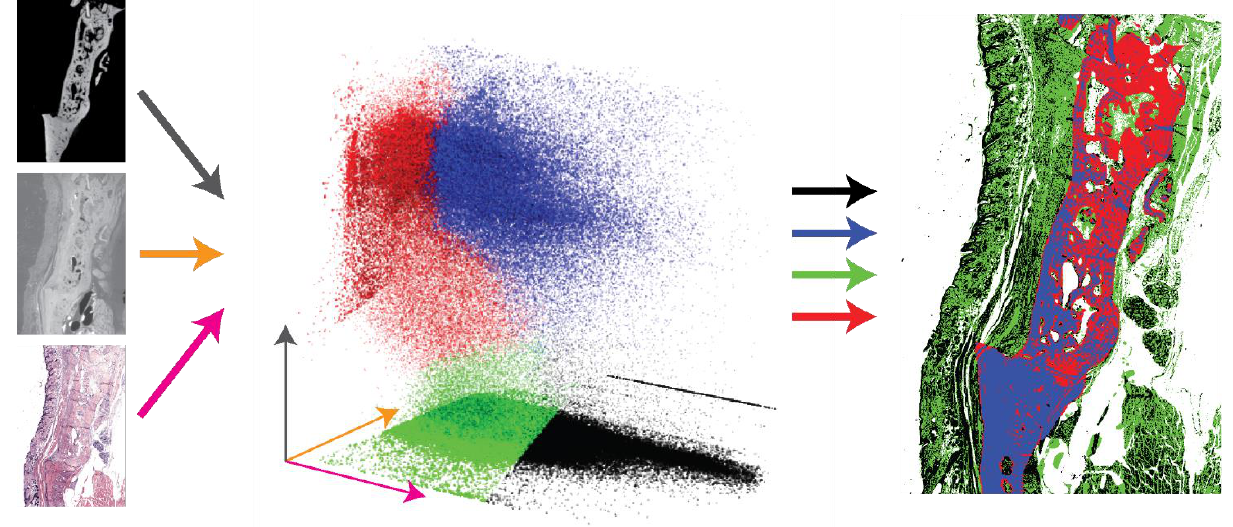
Figure 11. Using the corresponding pixel intensities of the three slices from conventional µCT before decalcification, from SRµCT after decalcification and from H&E-stained histology, a trivariate histogram was built. After applying k-means clustering, we identified five classes: mature bone (blue), newly formed bone (red), connective tissue with fat (green) and soft tissues with many nuclei (black).